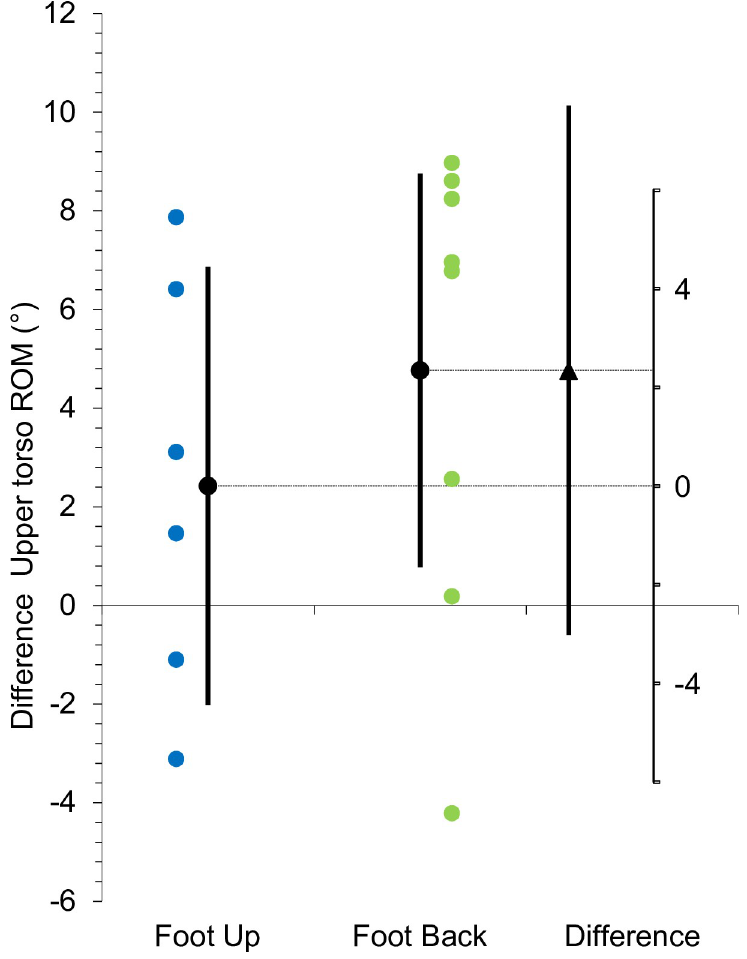
Fig 2. Subgroup analysis of side differences in upper torso range of motion between foot-up and foot-back players (95% CI).